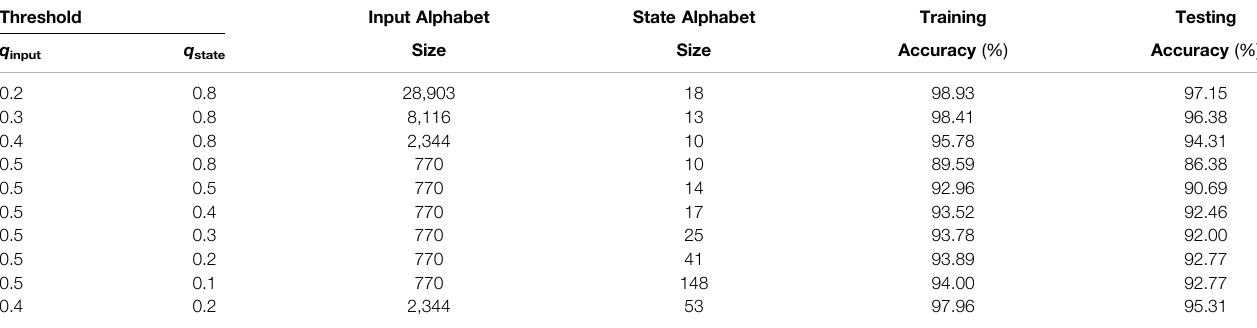
TABLE 4 | Performance of discretized 5-network KAARMA chains using MFCCs for the forward, left-to-right (L2R or → ) sequence processing.